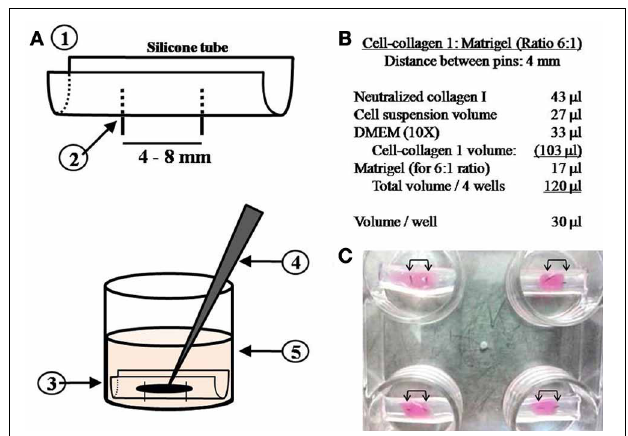
FIGURE 1 | Details on simple silicone tube chamber construction and hydrogel-cell preparation. (A) Biological grade silicone tubing is cut to fit the diameter of the well; the tube is then cut lengthwise in half (1). Surgical grade stainless steel pins are inserted through the silicone wall at predefined distances from each other (2). The silicone tube is secured in place within the well with Sylgard 182 to form a chamber (3). The hydrogel-cell suspension is pipetted into the silicone chamber around the pins (4) and the well is flooded with growth media once the gel construct has set (5). (B) Calculations for preparation of the hydrogel-cell mixture (Ratio of 6:1). (C) A multi-well plate containing a hydrogel-C2C12 mix seeded in silicone tube chambers (arrows indicate pins positioned 4mm